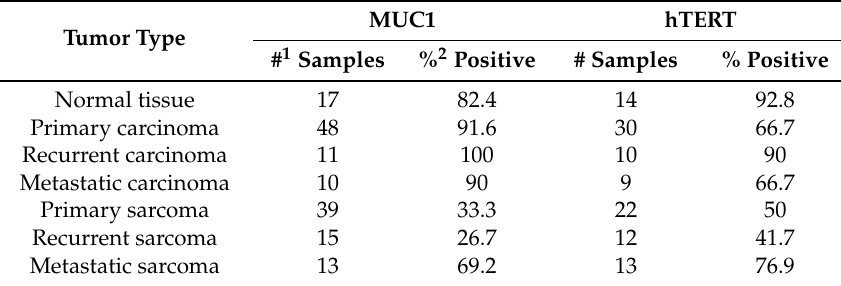
Table 2. Evaluation of TAA expression in patient biopsies by IHC.